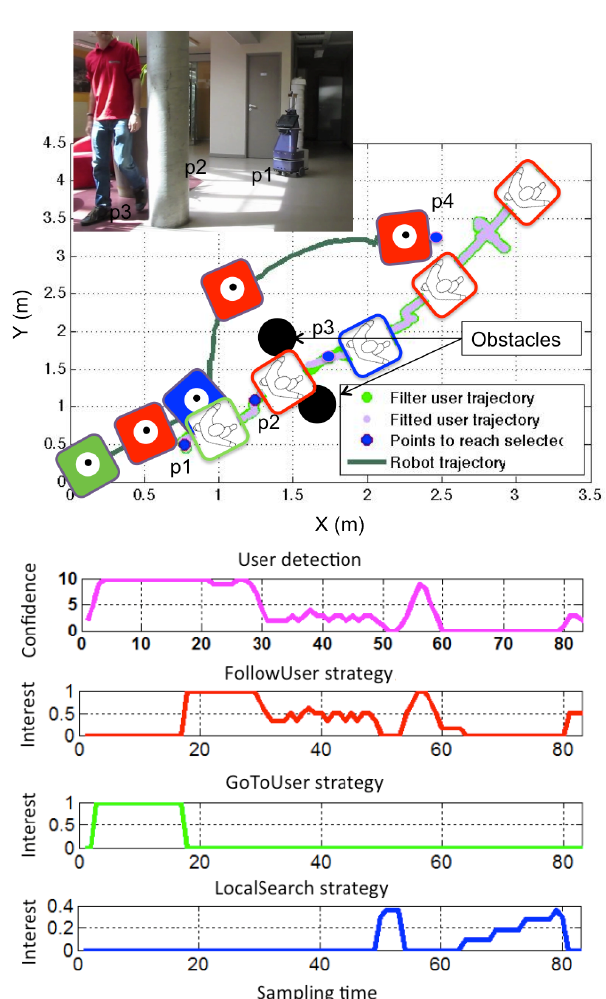
Figure 8. Top: Robot and person trajectories. Bottom: Strategy selection and person detection confidence during the experiment. Colors: red when the person is detected moving, green when is detected stand- ing and blue when is not detected at all.